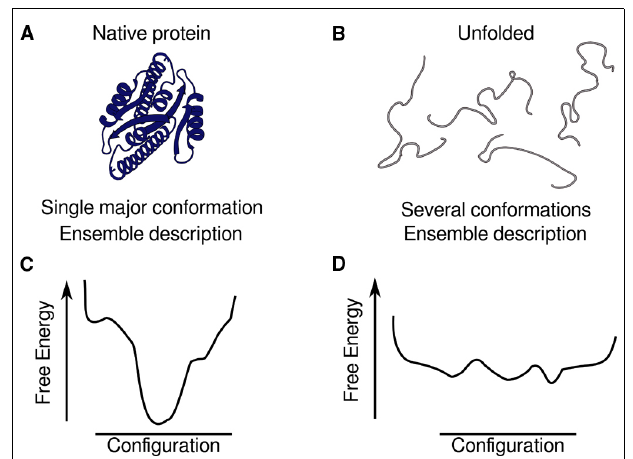
FIGURE 1 | Depiction of the ensembles of structures by conformational landscapes, with the location of minima, their depths and the heights of the barriers. Schematic representation of ensembles of structures for a globular, natively folded protein (A) and an intrinsically disordered protein (B) . The description of a globular protein is based on an ensemble of structures clustered around a deep global minimum that can have substates in it (C) but represent basically the same topology, whereas the description of an IDP is based on a dynamic ensemble of different conformations represented by a collection of minima with similar depths (D)